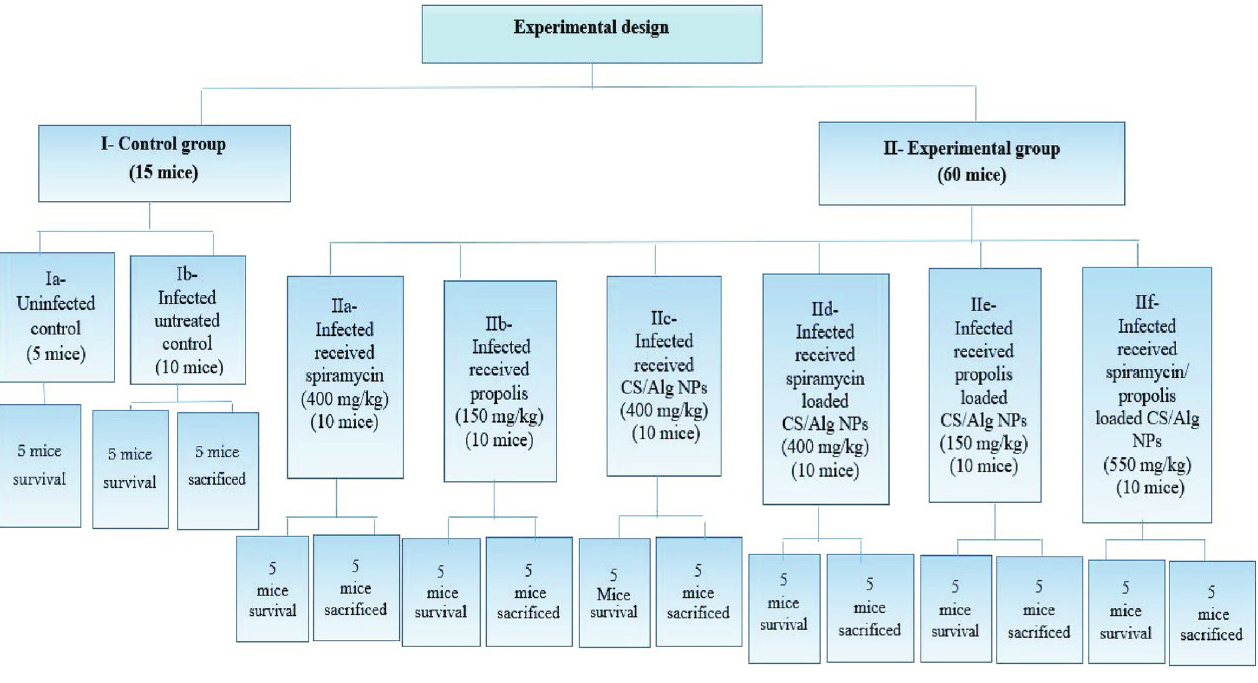
Fig 1. Experimental design of the studied